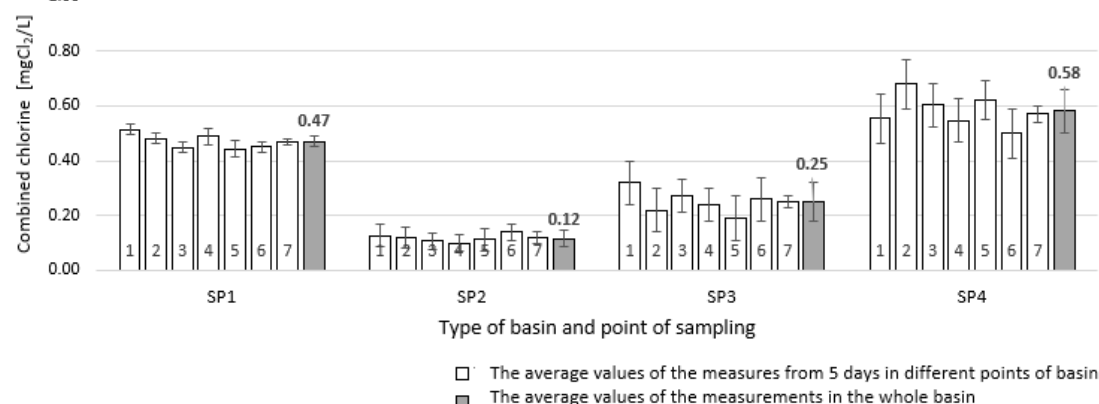
Figure 4. The distribution of combined chlorine in the selected points of the basins.